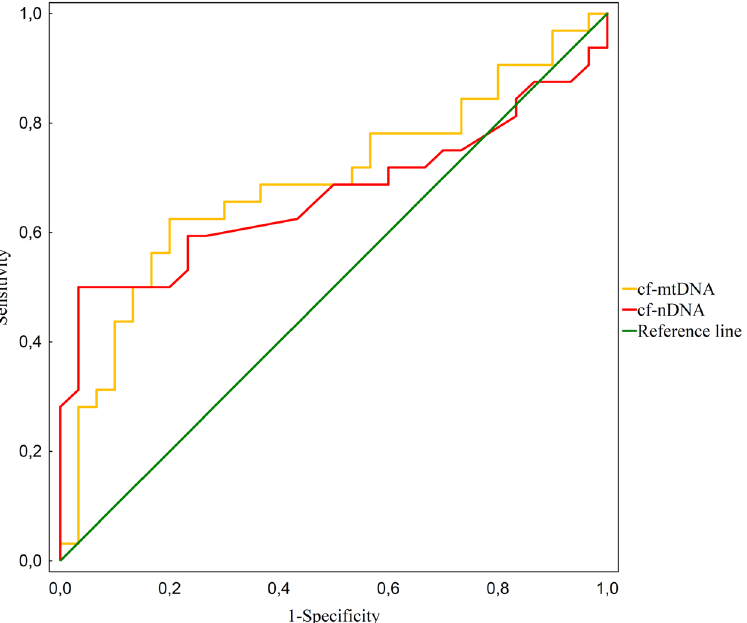
Figure 1. Receiver-operator characteristic (ROC) curves considering all the samples from the training data set (32 cancer cases and 30 controls) for the cf-nDNA and cf-mtDNA. The ROC curves plot sensitivity versus 1- specificity. The determined cut-off values for cf-nDNA and cf-mtDNA were 3 331 and 56 292,